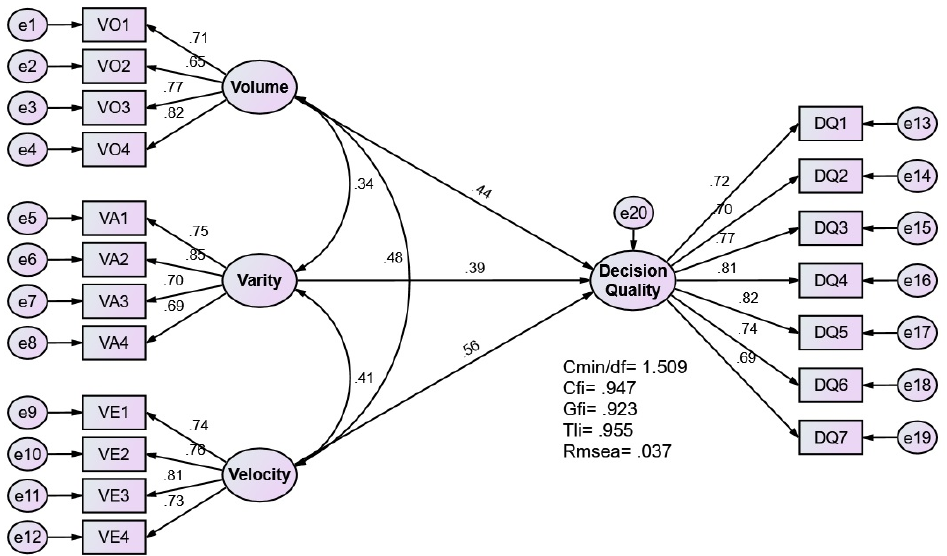
Fig. 2. SEM for testing the impact of big data on decision